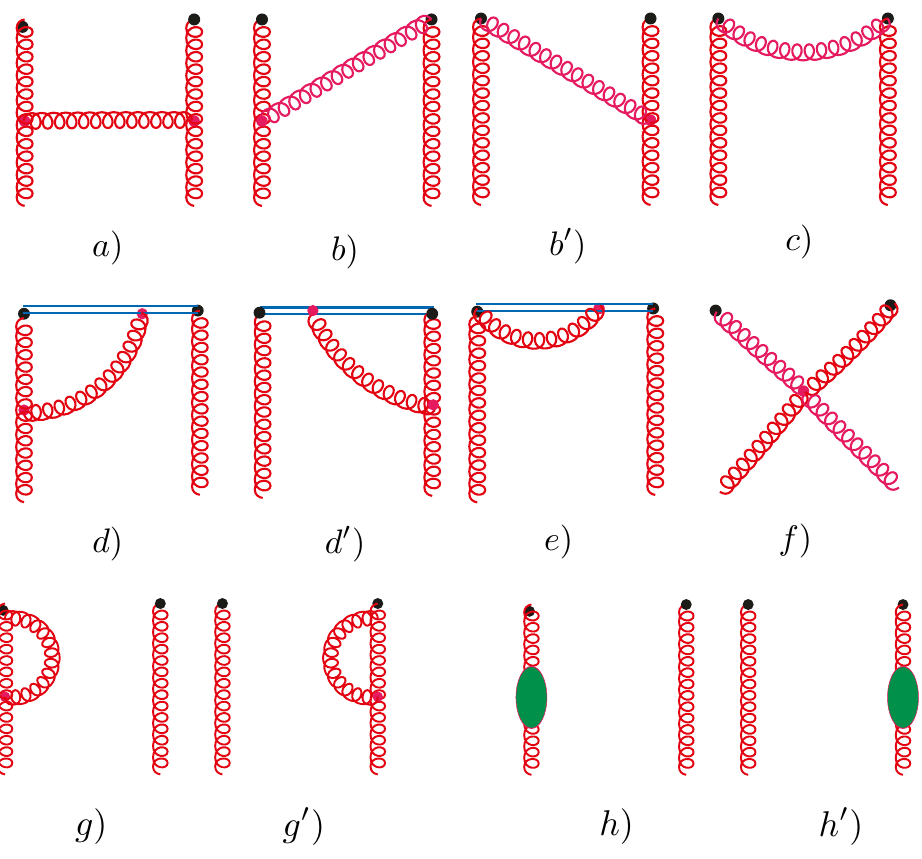
Figure 1 . One-loop diagrams (mirror diagram e 0 is not